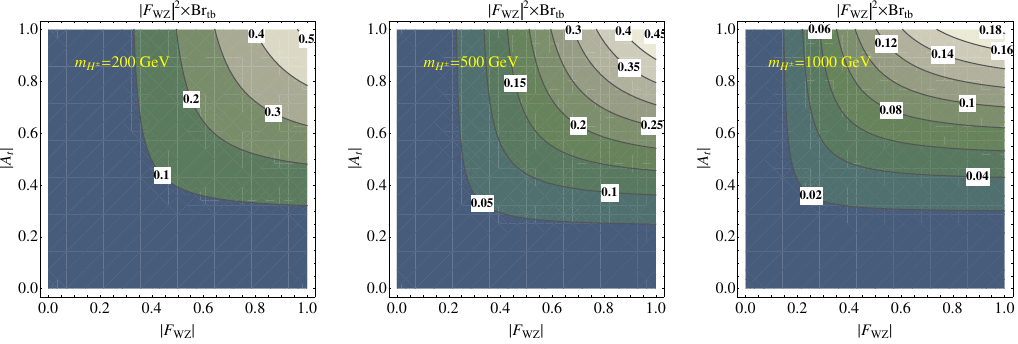
Figure 2 . Dependence of j F WZ j 2 (cid:2) B tb on j F WZ j and j A t j for m cuts signal t (cid:22) t tW tq cuts in eq. (2.6) (cid:1) R > 0 : 4 mn